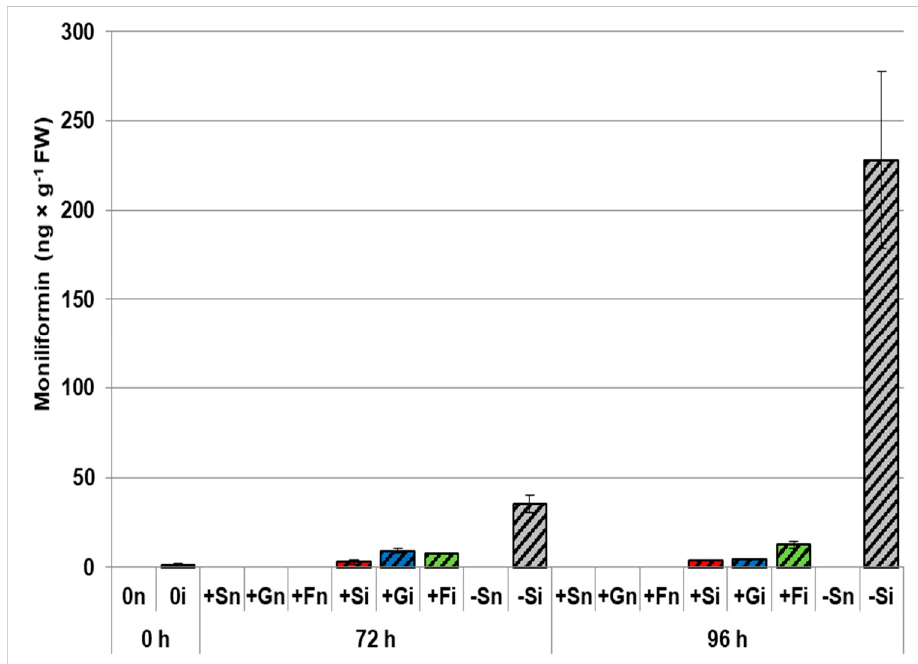
Figure 3. Effects of sucrose, glucose, and fructose on the accumulation of moniliformin in in vitro cultured embryo axes of Lupinus luteus infected with Fusarium oxysporum f. sp. lupini . (+Sn, non-inoculated embryo axes and cultured in vitro on Heller’s medium with 60 mM sucrose; +Gn, non-inoculated embryo axes and cultured in vitro on Heller’s medium with 120 mM glucose; +Fn , non-inoculated embryo axes and cultured in vitro on Heller’s medium with 120 mM fructose; − Sn, non-inoculated cultured in vitro on medium without sucrose; +Si, inoculated and cultured with 60 mM sucrose; +Gi, inoculated and cultured with 120 mM glucose; +Fi, and with 120 mM fructose; − Si, inoculated and cultured without sucrose). A summary of the statistical significance of differences between the average values of each pair at p < 0.05 can be found in the Supplementary Files (Table S3).